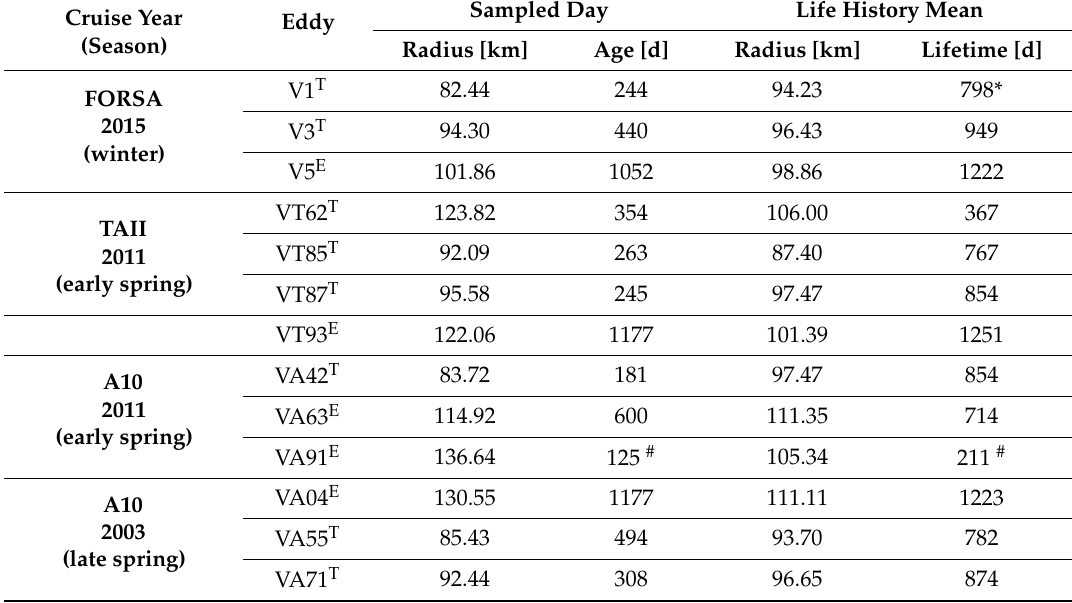
Table 1. Radius (km) and lifetime (d) of each eddy investigated on this study in the in situ sampling day and life history. Superscript T or E indicates whether the eddy can be considered a true or evolved eddy according to the classification of Orselli et al. [34]. * indicates that the eddy lifetime accounting was completed together with the data availability in the AVISO product until analysis. # indicates that the eddy was formed during the splitting of a 925 day old Agulhas